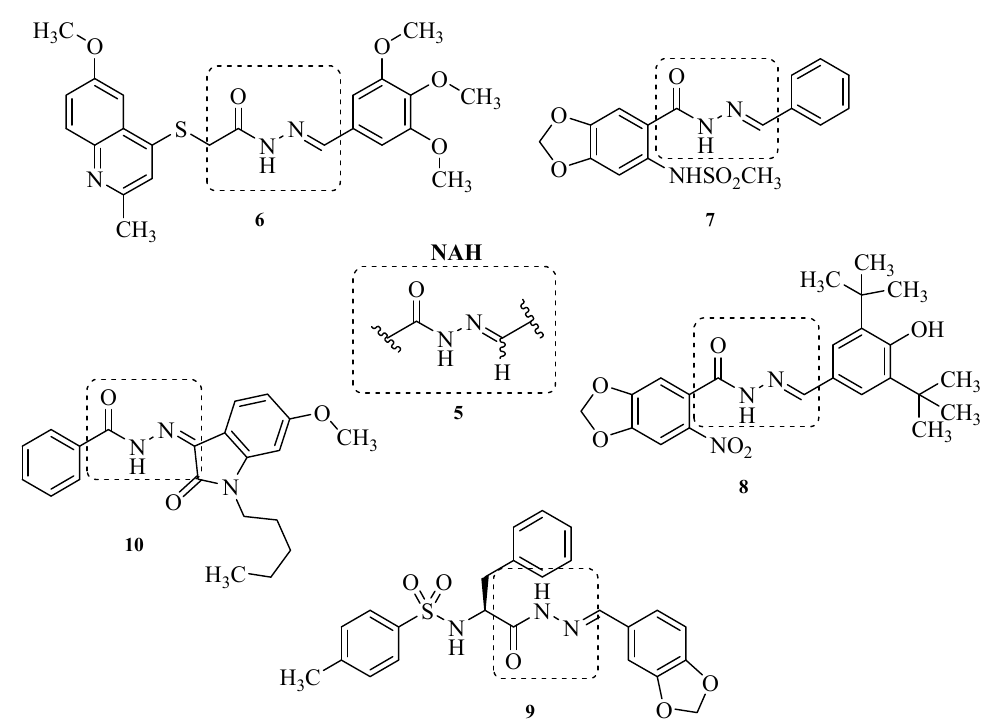
Figure 2. N -acylhydrazones derivatives with different activities.